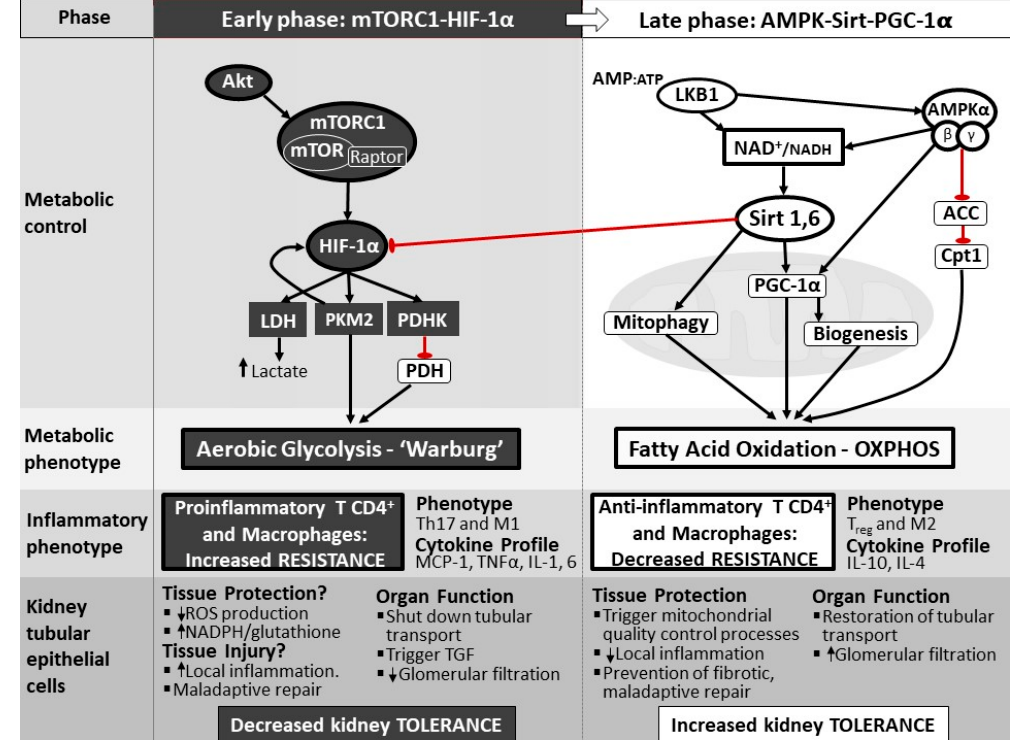
Figure 2. Hypothetical scheme of the regulatory nodes driving metabolic reprogramming toward aerobic glycolysis (left panel) or oxidative phosphorylation (right panel) in the kidney tubular epithelial cell. During early inflammation, activation of HIF-1 α through the Akt/mTORC1 pathway, results in the expression of PKM2 and PDHK, which inhibits the conversion of pyruvate into Acetyl CoA, and therefore its entry into the mitochondria. This early phase is followed by a late phase, where the cell returns to the default metabolic phenotype which relies on OXPHOS for energy production. This switch is led by the cooperative activation of AMPK, PGC-1 α , Sirt 1 and Sirt 6. AMPK, PGC-1 α and Sirt 1 are the key regulatory nodes that promote fatty acid oxidation and glucose oxidation (i.e., OXPHOS), whereas Sirt 6 may have a role in inhibiting the actions of HIF-1 α on glycolytic enzyme expression. ACC, acetyl co-enzyme A carboxylase; AMP, adenosine monophosphate; ATP, adenosine triphosphate; MCP-1, monocyte chemoattractant molecule 1; NAD+, nicotinamide adenine dinucleotide (oxidized); NADH, nicotinamide adenine dinucleotide (reduced); TH17, type 17 T helper; TNF, tumor necrosis factor; Treg, regulatory T cell. Modified from (Gomez H; Kellum J.A; Ronco C. Metabolic reprogramming and tolerance during sepsis-induced. AKI Nat Rev Nephrol. 2017 Mar, 13(3), 143–151 and Pool R; Gomez H; Kellum J.A; Mechanisms of Organ Dysfunction in Sepsis. Crit Care Clin. 2018 Jan, 34(1), 63–80).